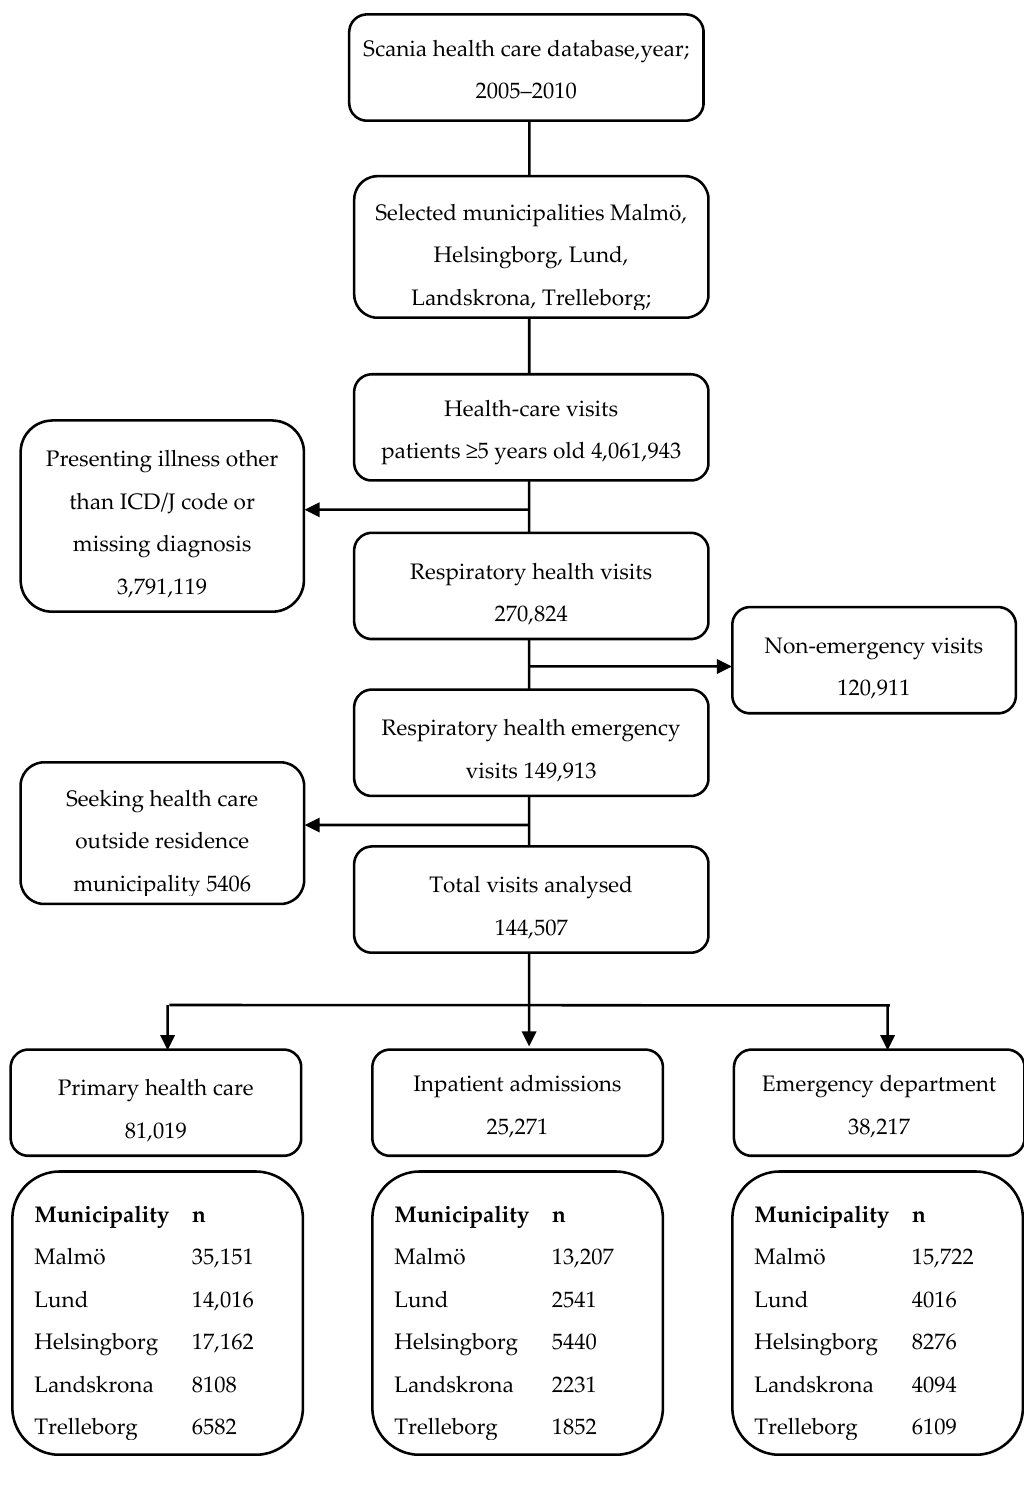
Figure 2. Flow chart showing the selection of health visits for five municipalities in the years 2005–2010.